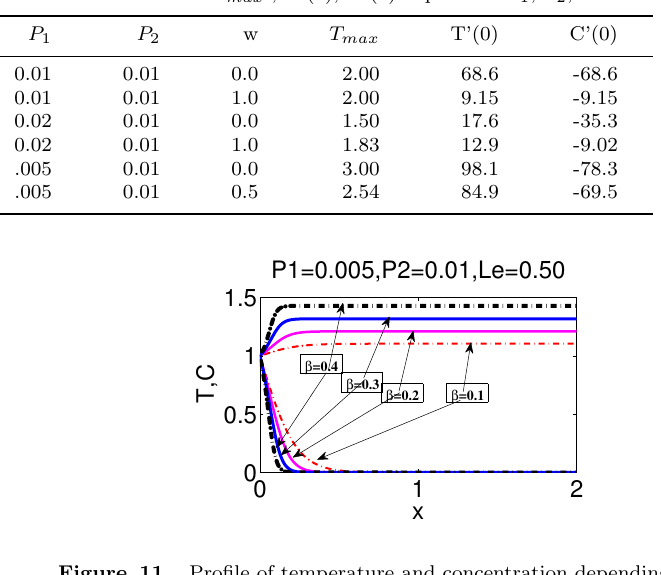
Figure 11. Profile of temperature and concentration depending on x for β = 0 . 1;0 . 2;0 . 3;0 .